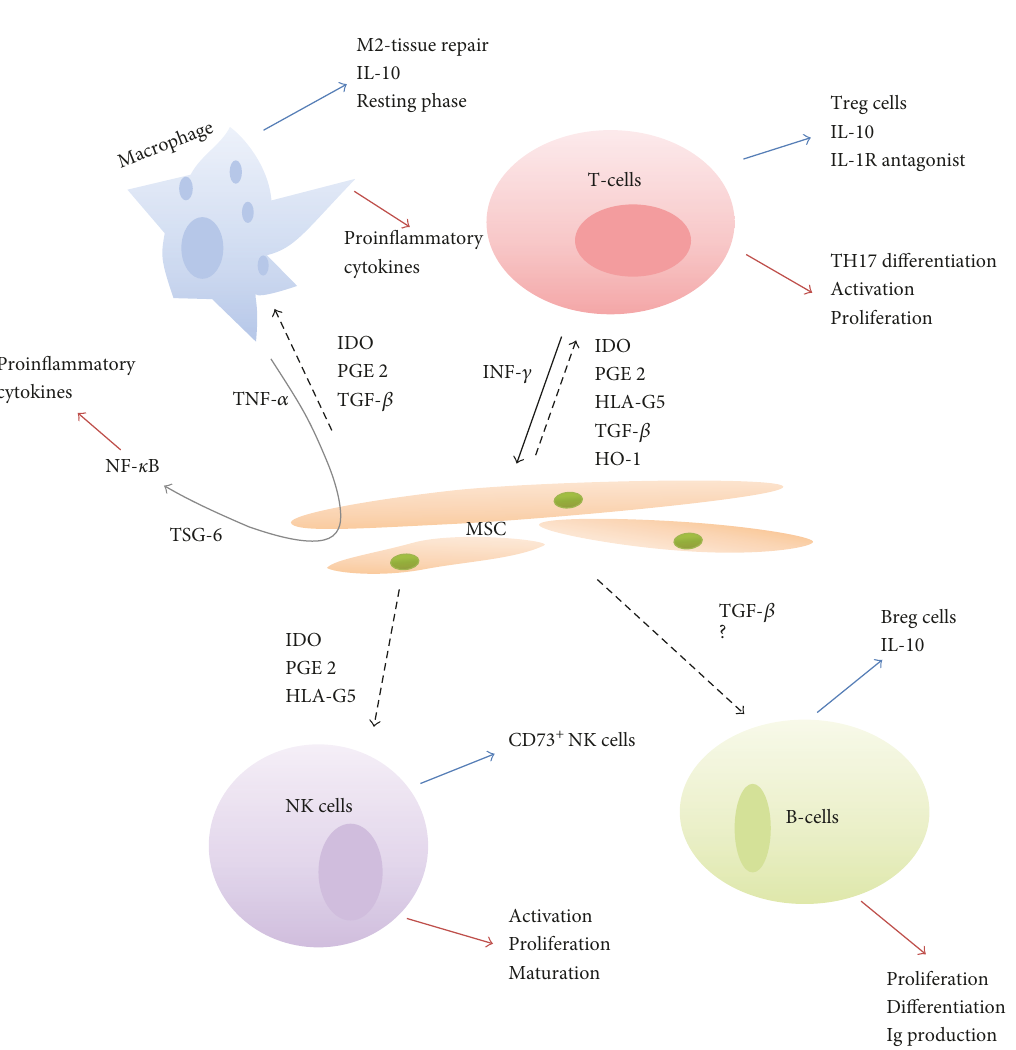
Figure 2: Known mechanisms of MSC immunomodulatory activity in